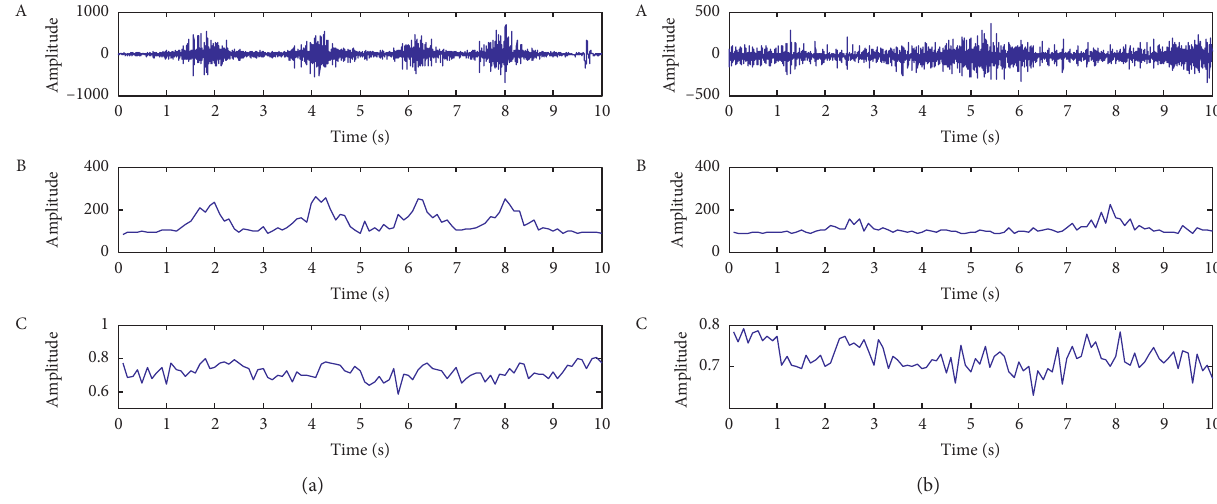
Figure 8: (a) sEMG signal from TM (A), WA (B), and PE (C). (b) MMG signals from AD (A), WA (B), and PE (C).